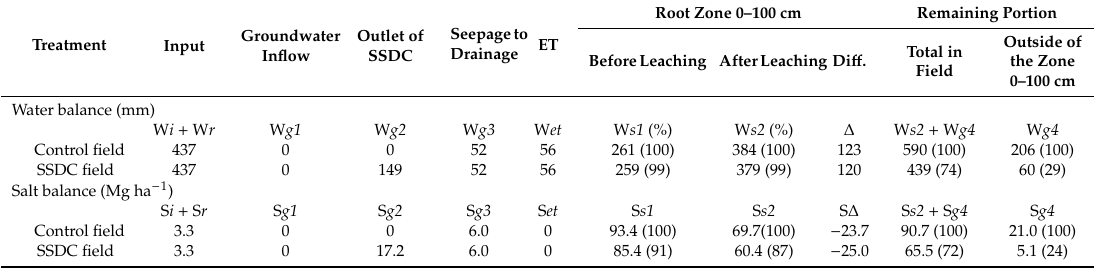
Table 2. Water and salt balance with / without the SSCD during the leaching